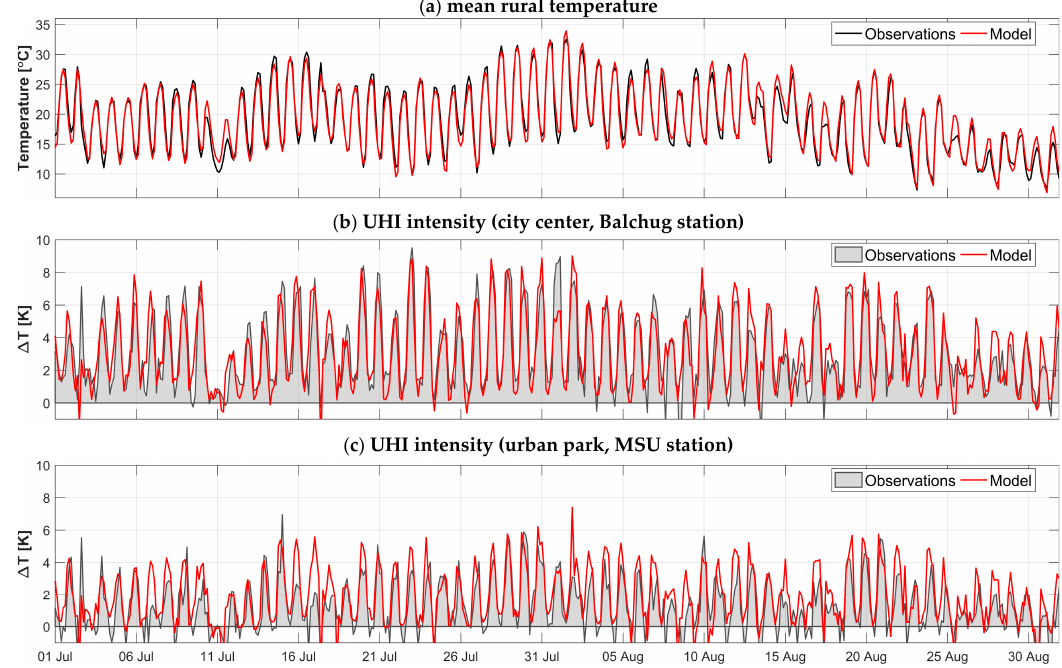
Figure 2. Temporal variation of: the mean rural temperature ( a ); and urban heat island (UHI) intensity ( Δ T) for two urban stations ( b , c ) according to observations and modeling results during July–August 2014. Mean rural temperature are averaged for each moment over nine rural stations around Moscow; UHI intensity is defined as the difference between the temperature at certain urban station and the mean rural value.